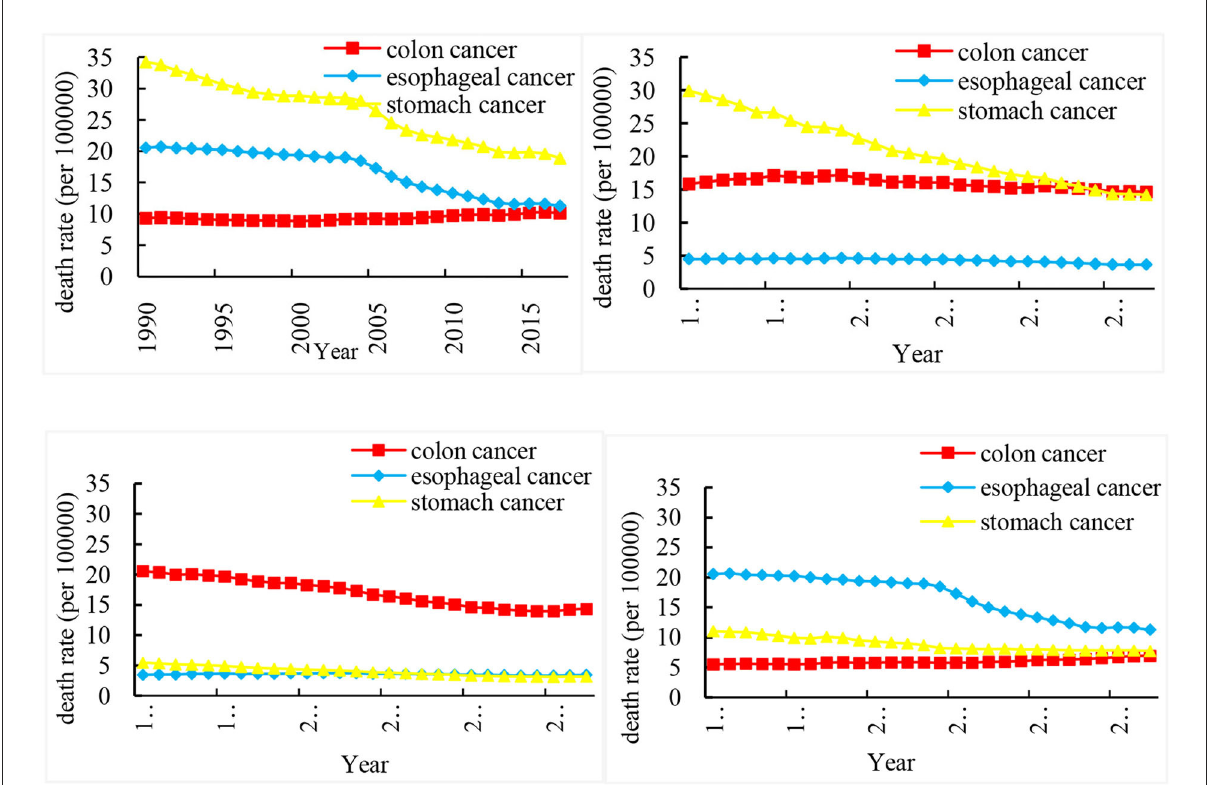
FIGURE1 Trends in the age-standardized rates of three cancer deaths in China, Japan, US, and India from 1990 to